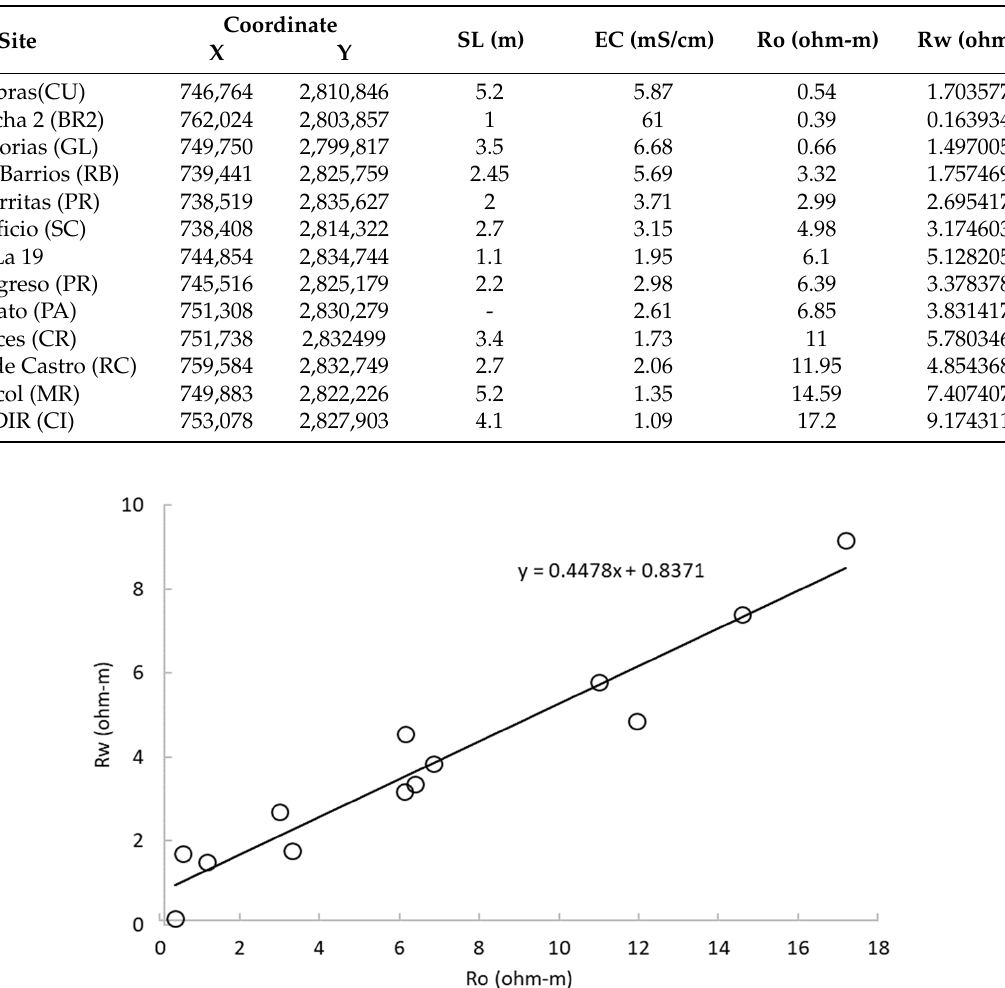
Table 3. Data obtained from static level depth (SL) and electrical conductivity (EC) of the aquifer water, resistivity of the saturated formation (Ro) and electrical resistivity of the aquifer water (Rw).